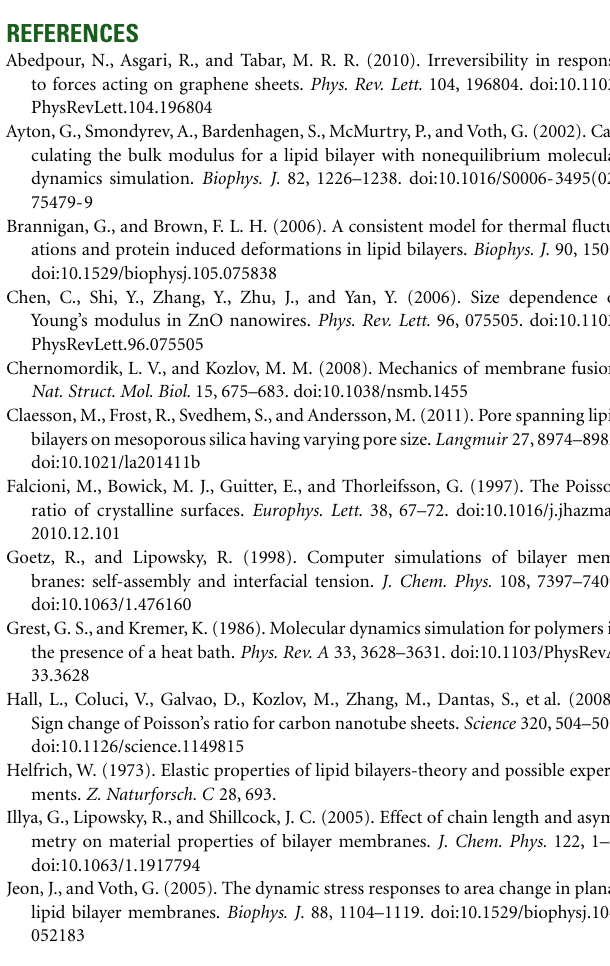
applied during actuation and sensing (Chen et al.,2006;McDowell et al.,